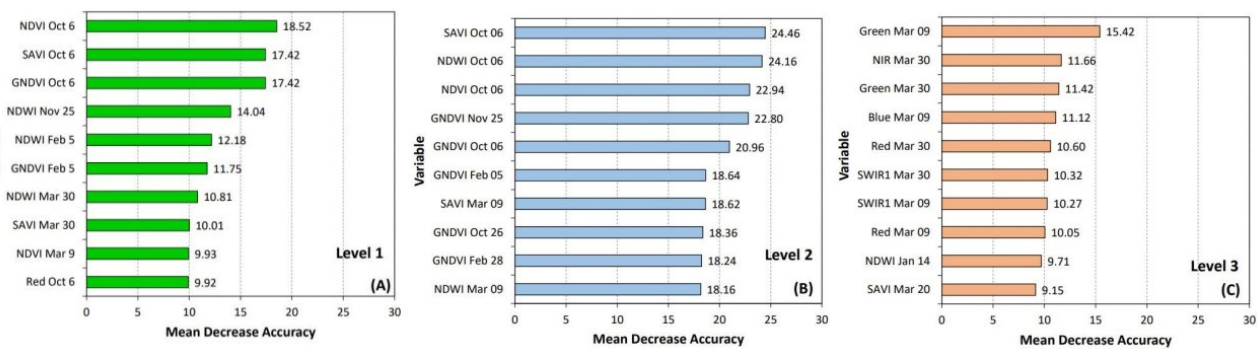
Figure 7. Measures of the importance of the Random Forest top 10 predictor variables for Level 1 ( A ), Level 2 ( B ), and Level 3 ( C ) hierarchical classifications based on the Harmonized Landsat Sentinel-2 (HLS) datasets. The months’ names are abbreviated as Oct (October), Nov (November), Feb (February), Mar (March), and Jan (January).